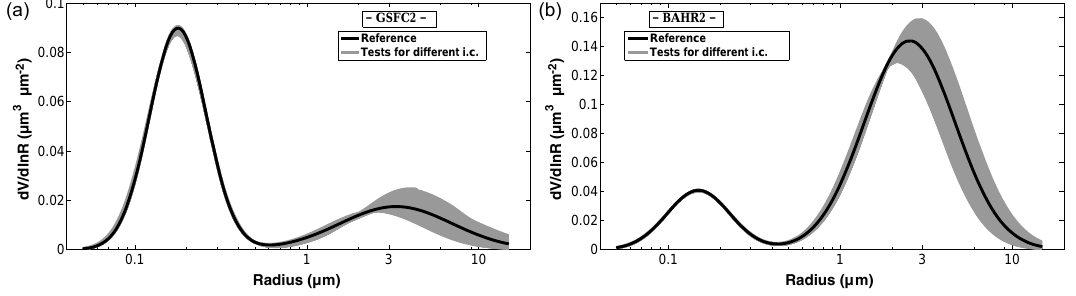
Figure 4. Size distribution retrieved in the multiple initial guess analyses for GSFC2 (a) and BAHR2 (b) . Black solid lines are used to represent the reference values, while the grey lines illustrates all the retrievals of the multiple initial guess analysis. Table 6. Sensitivity of multiple initial guesses to the GRASP-AOD inversion. The averages and the standard deviations of the retrievals are presented for six primary parameters (volume median radius ( r V concentration ( C V , C V [µm 3 µm − 2 ])) in the first six columns (reference values in Table 1). The last two columns contain the averages and c f the standard deviations of the two secondary products (fine-mode aerosol optical depth at 500nm ( τ f ( 500 ) ) and the effective radius ( r eff